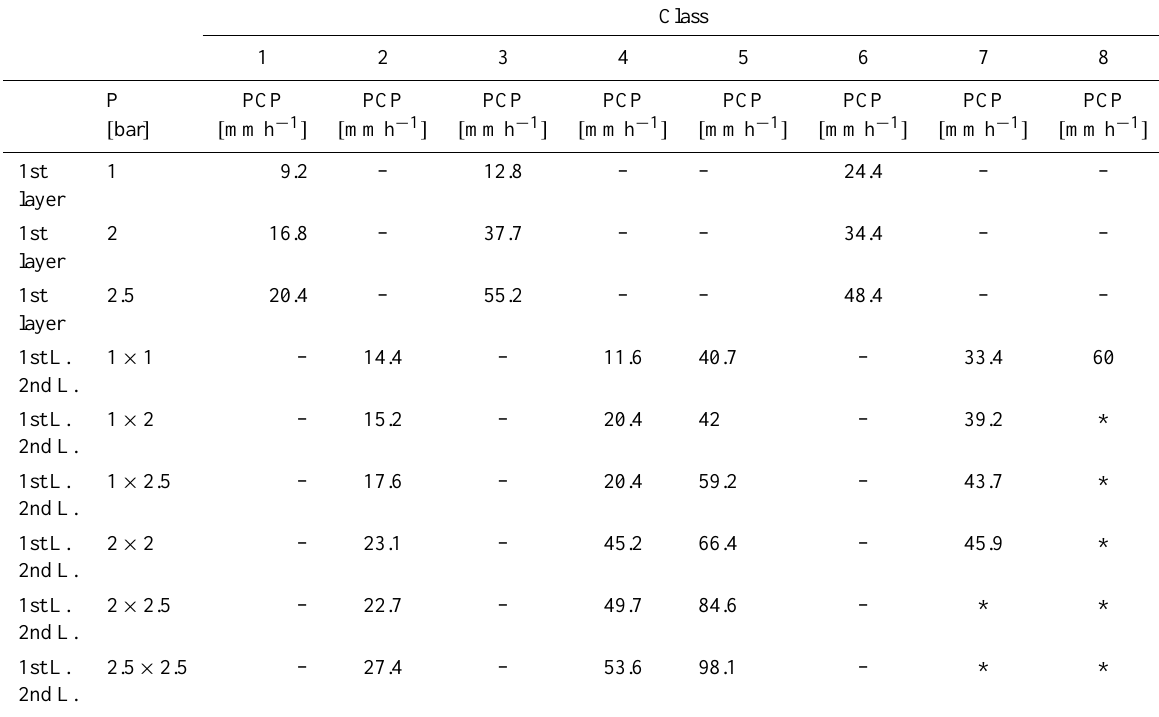
Table 3. Applied pressures and corresponding produced rain